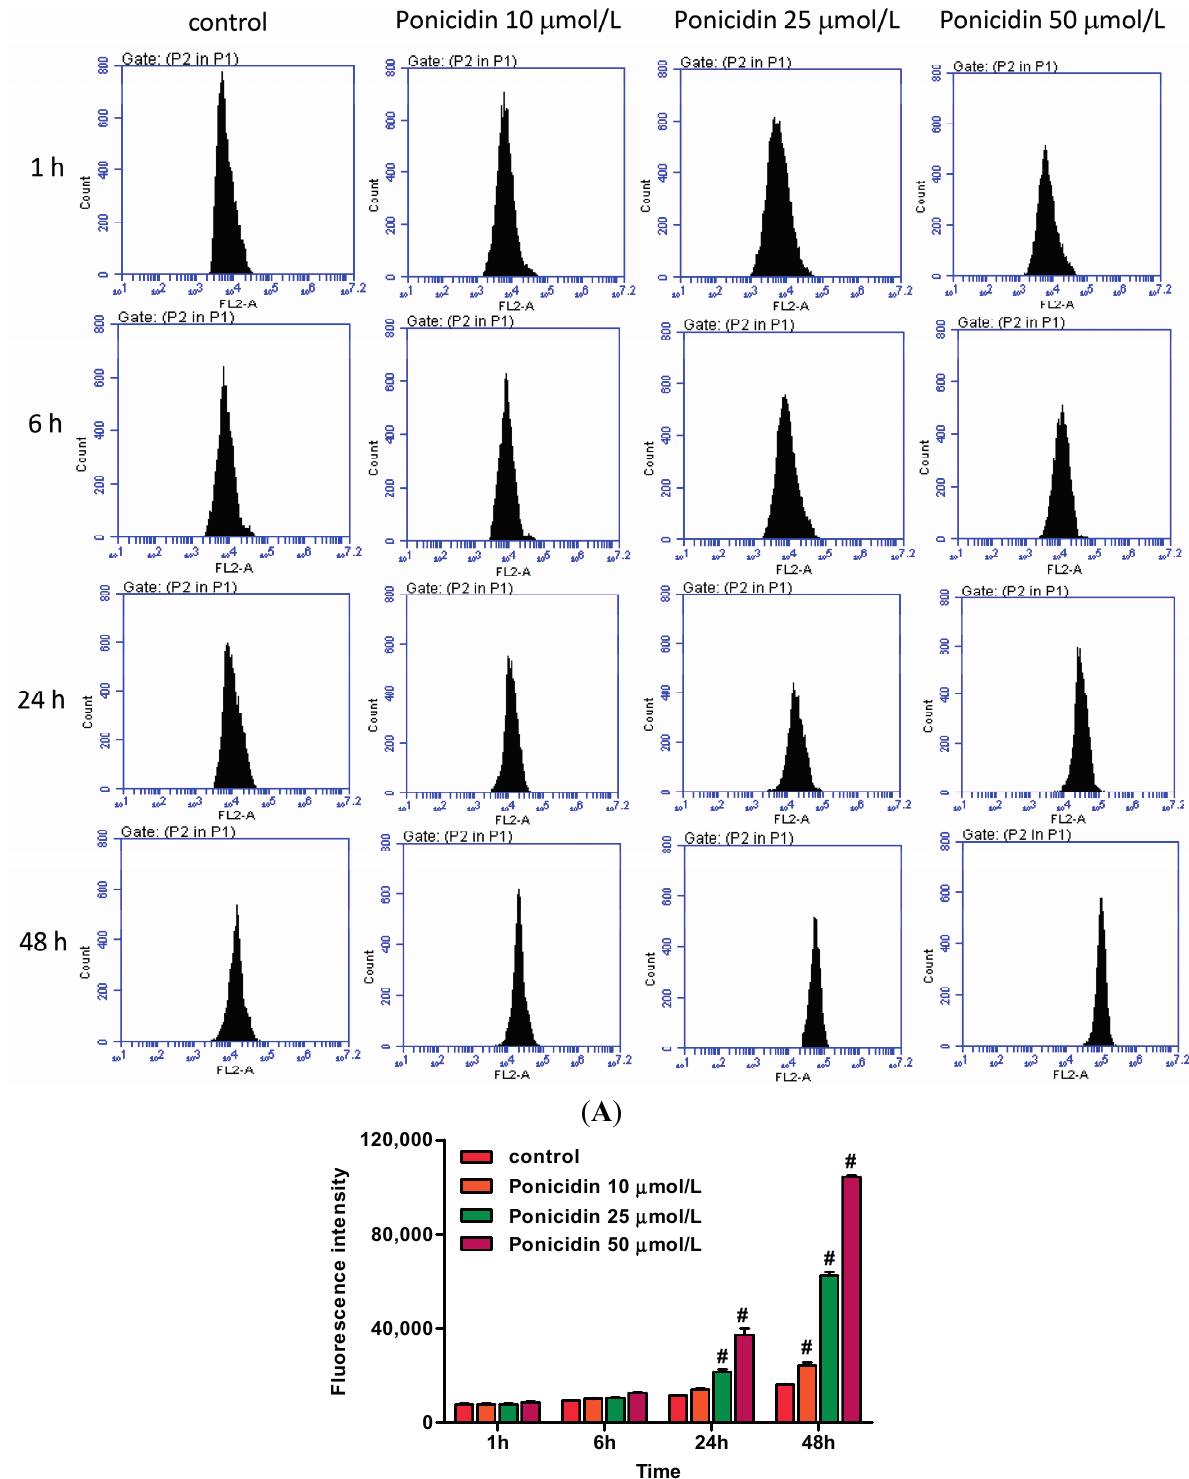
Figure 4. Effects of ponicidin on ROS generation in MKN28 cells. ( A ) After treatment with ponicidin at doses of 10, 25 and 50 μ mol/L for 1, 6, 24 and 48 h, cells were resuspended with 50 μ mol/L DHE and analyzed by flow cytometry; and ( B ) Ponicidin treatment time- and dose-dependently increased ROS generation of MKN28 cells. # p <